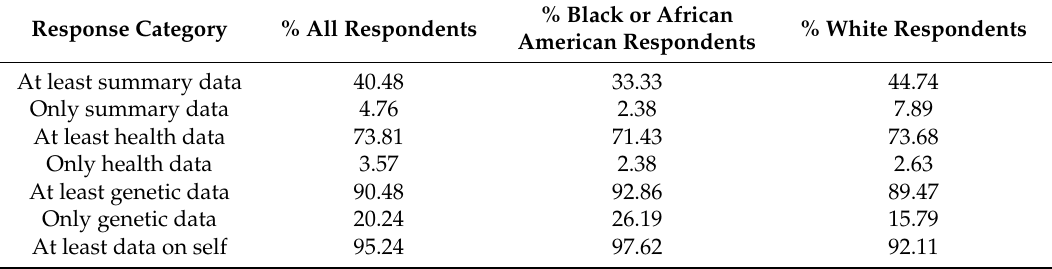
Table 4. Return of research results preferences among respondents who want results. Of the 103 survey respondents, 94 answered this question. From this, we excluded respondents who did not want